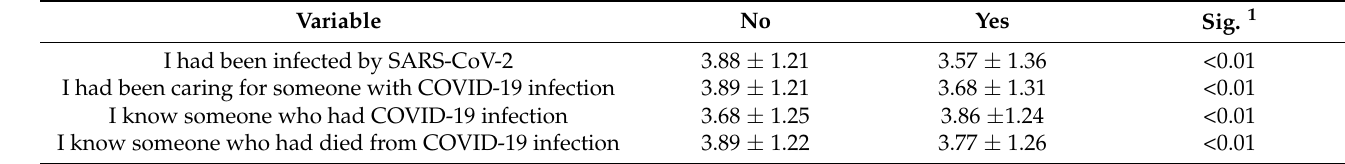
Figure 2. Dental students’ COVID-19 vaccine acceptance by ( a ) economic level and ( b ) geographic region, February 2021. Table 7. Dental students’ COVID-19 vaccine acceptance and COVID-19-related experience, February 2021.